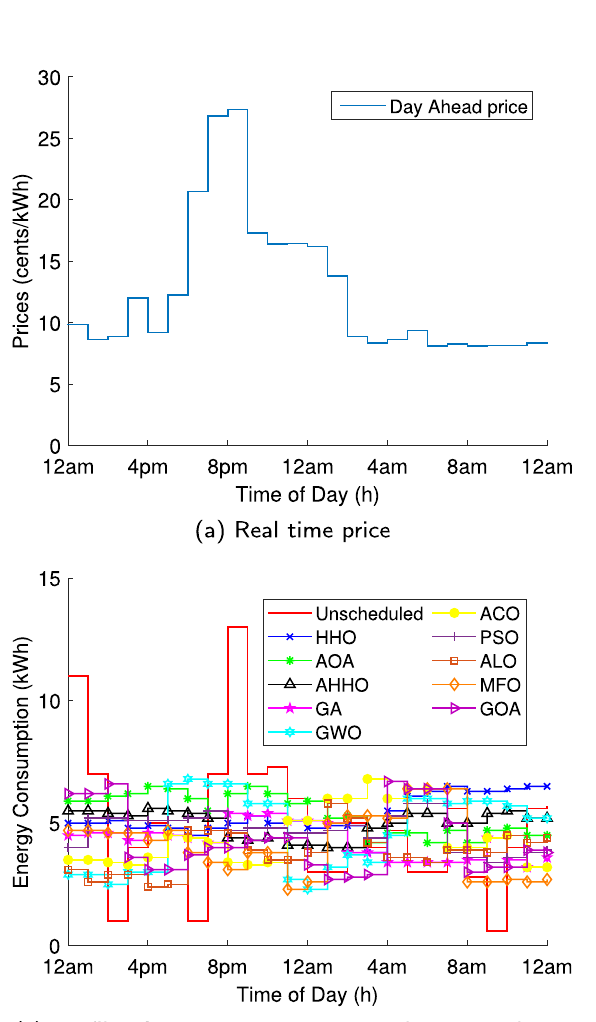
Fig. 5 Pricing schemes and energy consumption